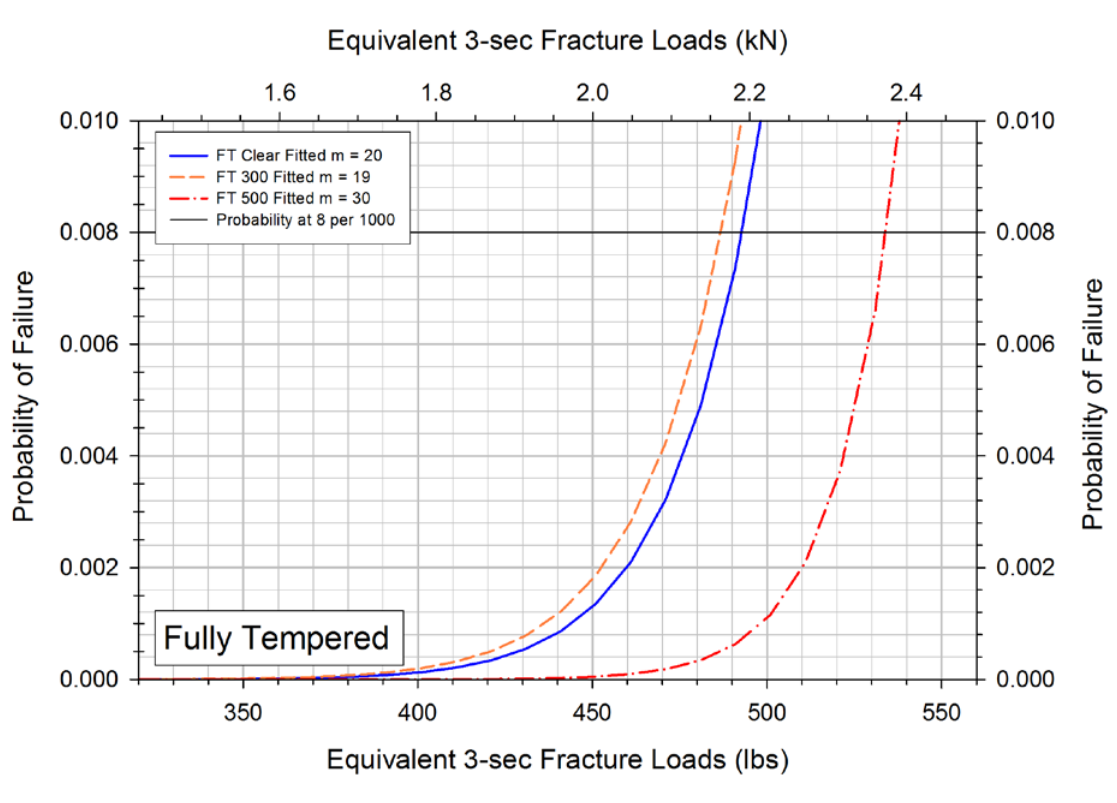
Figure 7. Fitted cumulative distribution function for the probabilities of failure less than or equal to 10 per 1000 for clear FT, OPACI-COAT-300®, and OPACI-COAT-500®